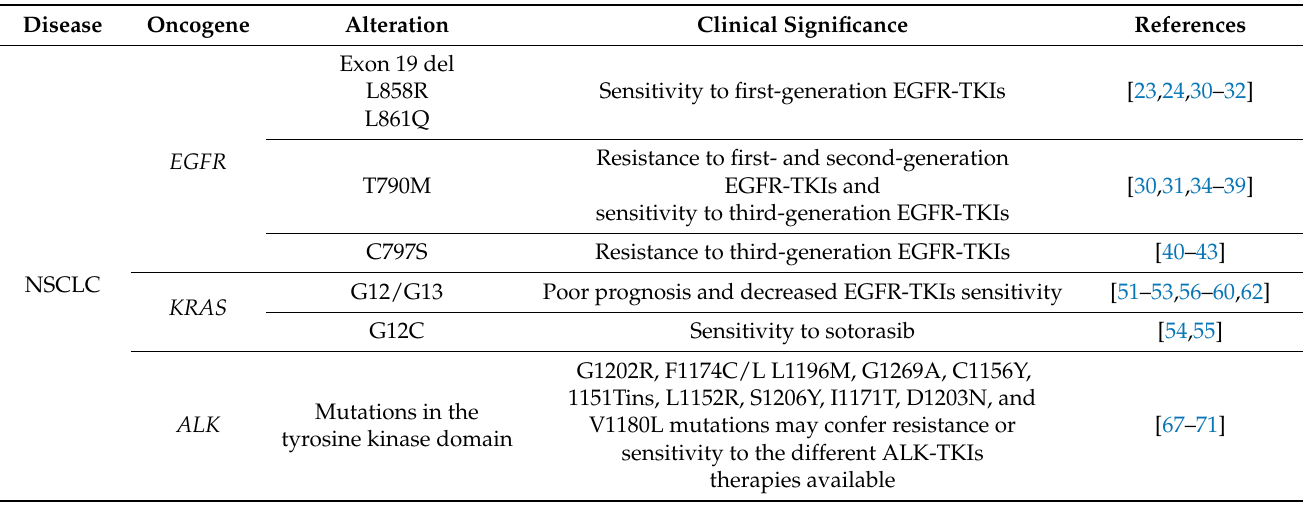
Table 2. The most relevant molecular alterations detected via ctDNA ddPCR assays and their clinical significance in NSCLC. Disease